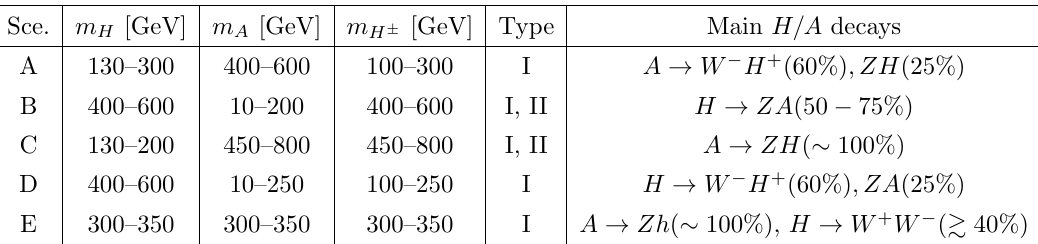
Table 4 . Benchmark scenarios leading to the SFOPT. Mass spectra and the main decay modes of the heavier neutral Higgs boson ( H or A ) are given in each scenario.The numbers in the parenthesis following each decay indicate an estimate on the branching